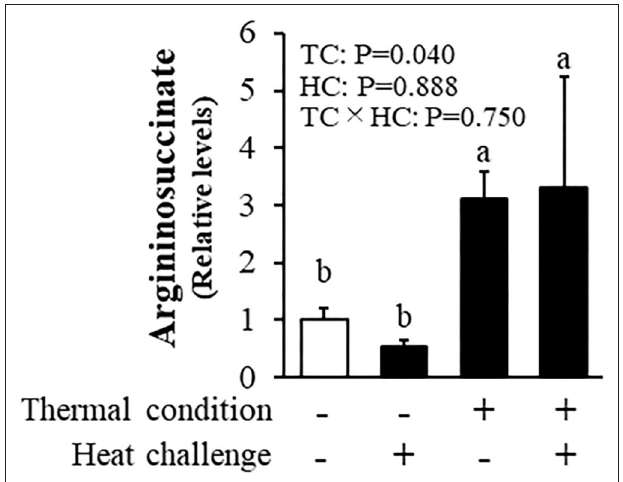
FIGURE 5 | Effect of thermal conditioning on levels of hepatic argininosuccinic acid in chicks. TC, thermal conditioning; HC, heat challenge. The number of chickens in each group was n = 4. + : treatment, –: non-treatment. There is a significant difference between different characters.